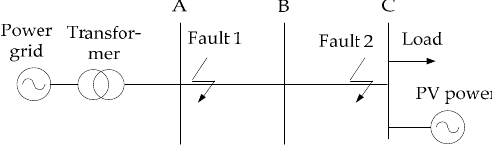
Figure 6. Simulation model of Large power grid including PV power.